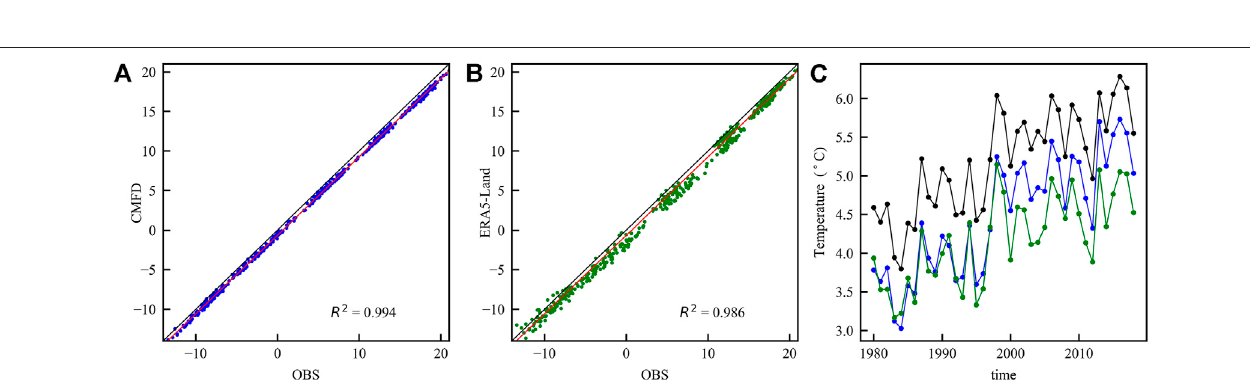
FIGURE 7| Scatter plots ofthe site observations versus monthly temperature estimates derived from (A) CMFD and (B) ERA5-Land. The black solid lineis the 1:1 line,andtheredsolidonerepresentsthelinearregression fi ttingline. (C) TimeseriesofmeanmonthlytemperatureintheQilianMountainsfortheperiod1980 – 2018,from observations (OBS, thin black line), CMFD (thin blue line), and ERA5-Land (thin green